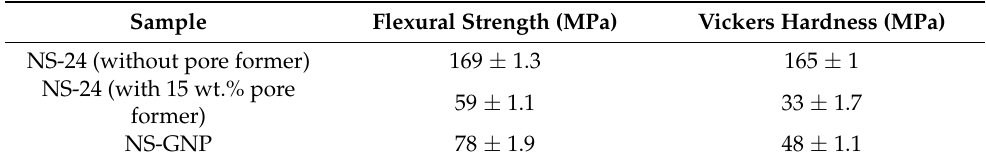
Table 2. Hardness and flexural strength of Ni–SDC cermet anode prepared using different synthe- sis